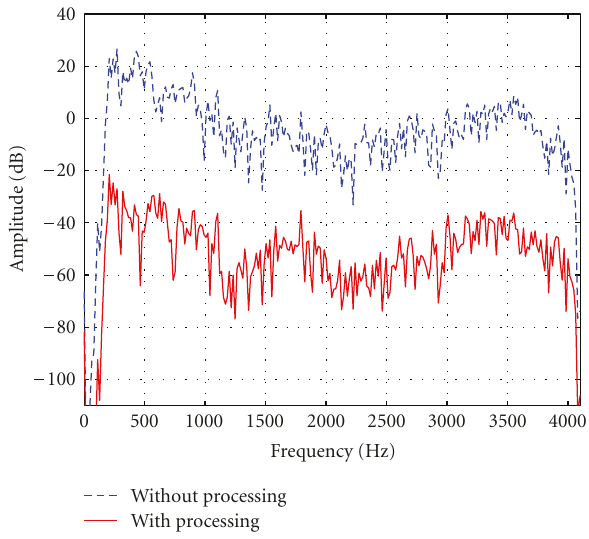
Figure 6: Example of frequency characteristics of observed sig- nal obtained by proposed method with 36 loudspeakers and 6 microphone elements. The signal is observed at the microphone near the user. The position of interference is number 1 in Figure 3.